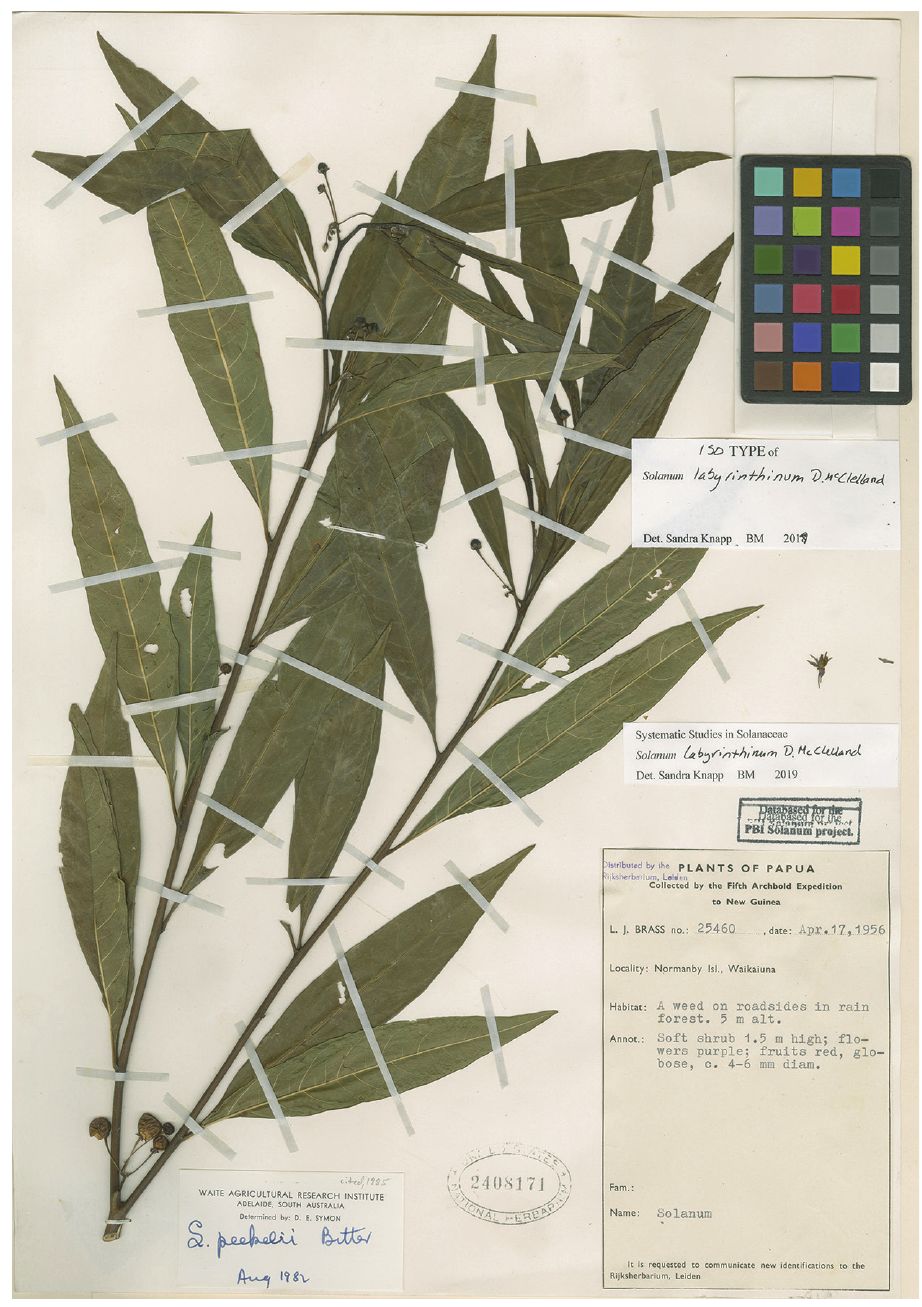
Figure 1. Solanum labyrinthinum D.McClelland (isotype Brass 25460 , US [acc. # 2408171]). Repro- duced with